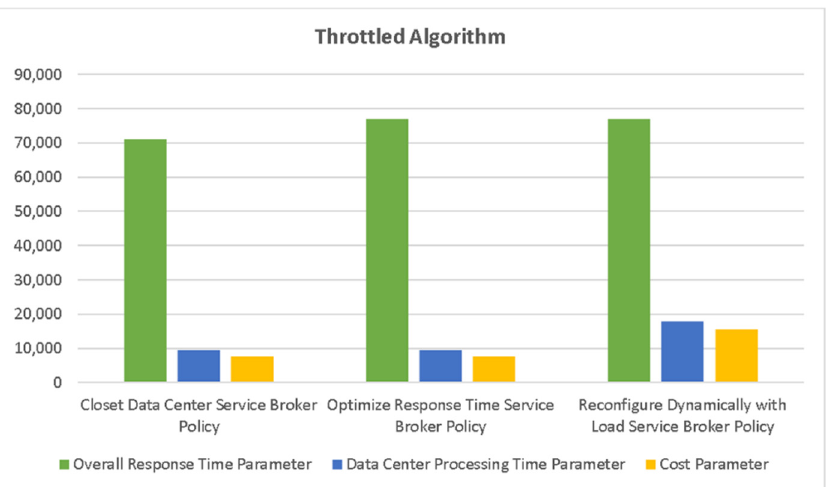
Figure 13. The analysis of the performance parameters of the ESCE algorithm on 3 service broker policies.